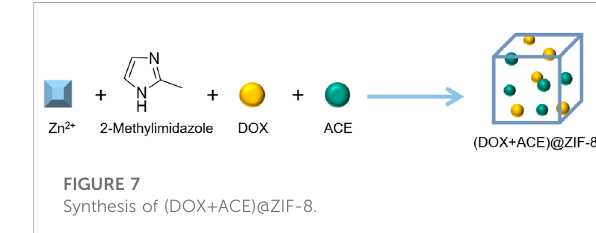
FIGURE 7 Synthesis of